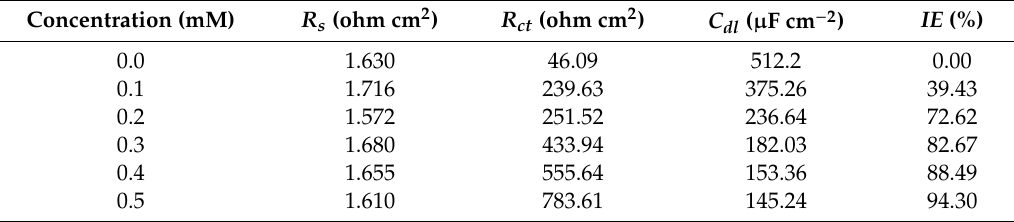
charge transfer of resistance, and double-layer charge respectively.